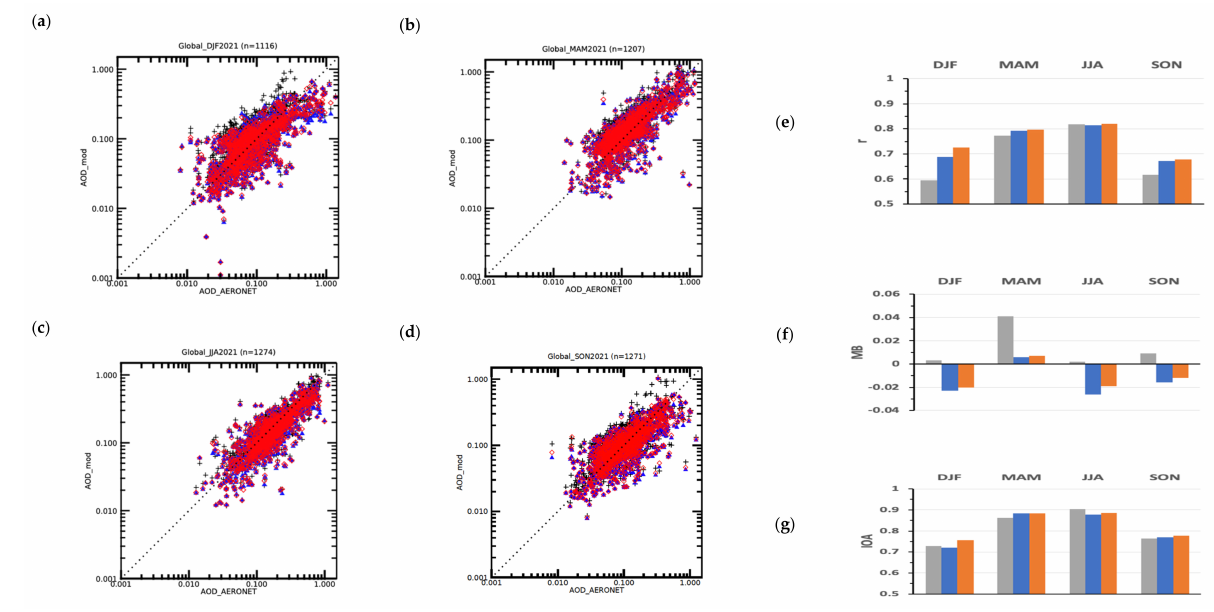
Figure 9. The scatter plots of global seasonal means of the GEFS AODs against AERONET AOD on global scales in ( a ) DJF, ( b ) MAM, ( c ) JJA and ( d ) SON of 2021 (n indicates the number of data points). (Black, blue, and red symbols indicate BASE, SENS1 , and SENS2 , respectively. The 1:1 dotted line is inset). Bar graphs in the right column are the statistics such as ( e ) correlation, ( f ) mean bias, and ( g ) Index of Agreement. (Gray, blue, and orange bars indicate BASE, SENS1 , and SENS2 , respectively).